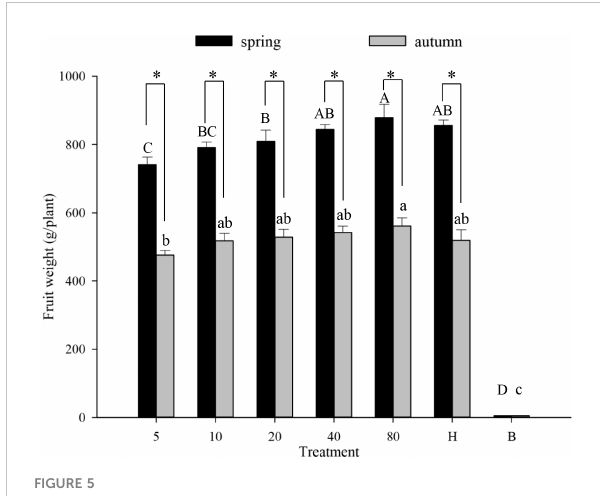
FIGURE 5 Fruit weight of muskmelon (g/plant) in different experimental treatments during spring and autumn 2020-21. Numbers in the X axis refer to the total number of hover fl y adults that were released i.e., 5, 10, 20, 40 or 80 pairs; data are also plotted for hormone (H) and bagging (B) treatments. Different uppercase and lowercase letters indicate statistically signi fi cant differences between treatment groups during either season (One-way ANOVA, P <0.05, Tukey ’ s HSD post-hoc ). Asterisks refer to seasonal differences in fruit weight under the same treatment.